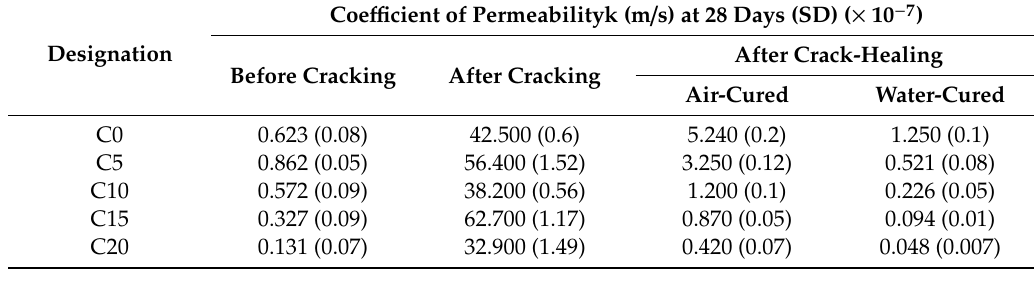
Table 7. Water permeability coefficient k variations due to the crack healing effect of MRGC.